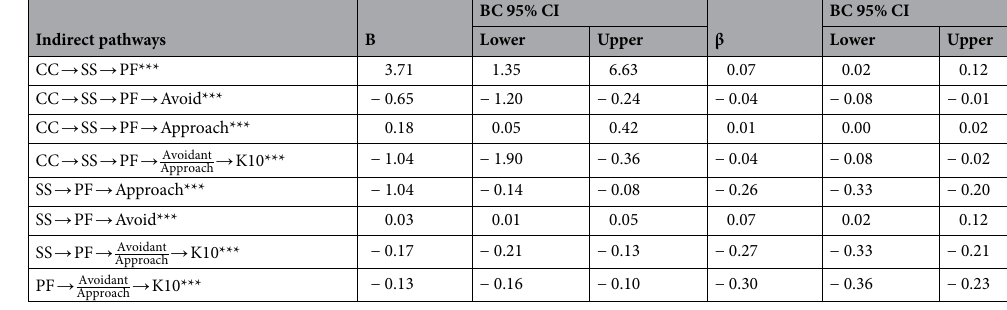
Table 2. The indirect pathways in the tested model (i.e., Fig. 2). Unstandardised Beta weights and standardised beta weights and their associated bias-corrected (BC) 95% confidence intervals. * p < 0.05; ** p < 0.01; *** p < .001. CC = COVID-19 Concerns; SS = Social Support; PF = Psychological flexibility, Avoid = Avoidant coping; Approach = Approach coping; and K10 = Psychological